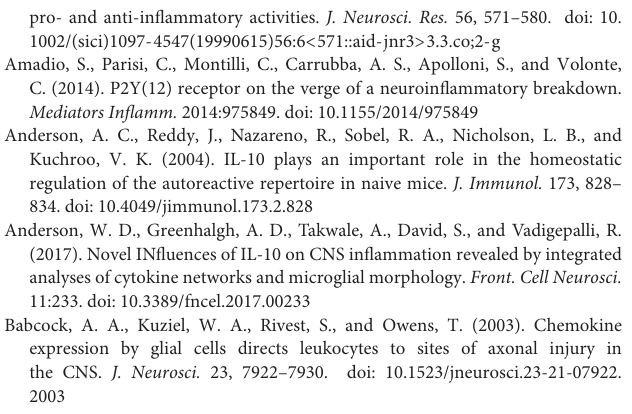
FIGURE S1 | Isolated CD11b + cells cultured in 8-well chamber slides develop from (A) round shaped cells at day 1 to cells with growing cell extension at (B) day 4, (C) day 7, and (D) after 12 days in cell culture to a dense network of cells (Magnification × 200). FIGURE S2 | Gating Strategy for primary microglia in flow cytometry. (A) Microglia in SSC/FSC profile, (B) microglia stained with the live-dead dye eFluor450. Living cells (FVD eFlour450 negative) are shown in region 1 (R1), (C) isotpye control IgG2b κ BV510 and IgG1 κ APC, (D) CD11b + BV510 cells with IgG1 κ APC Isotype control, and (E) intracellular cytokine staining of CD11b + cells with anti-IL-6 APC. FIGURE S3 | NO release of WT (black bars) or IL-10 KO (gray bars) microglia of control group or after LPS treatment. NO content in µ M ( N = 12) in the supernatant of microglia. Mean ± SEM. One-way ANOVA. ∗∗∗∗ p < 0.0001. TABLE S1 | Cytokine/Chemokine